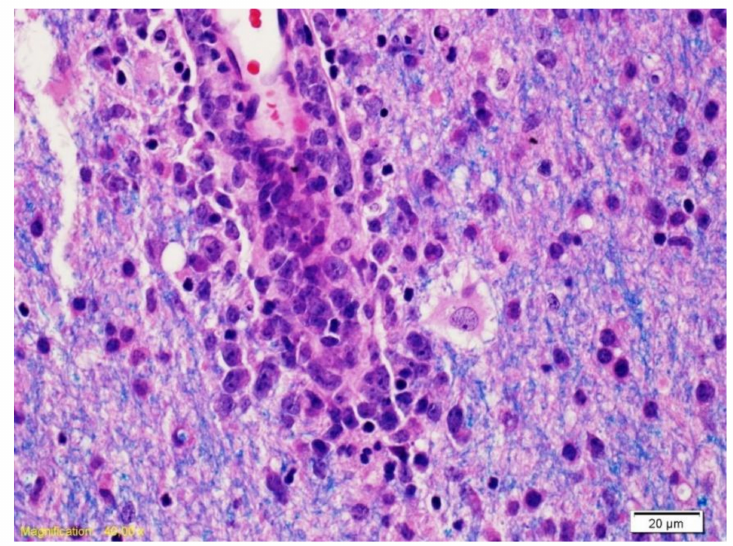
Figure 3. The Luxol Fast Blue coloration combined with hematoxylin / eosin (LFB / H&E) highlights a vessel surrounded by cells with large nucleolus nuclei corresponding to neoplastic B lymphocytes and myelin (blue).